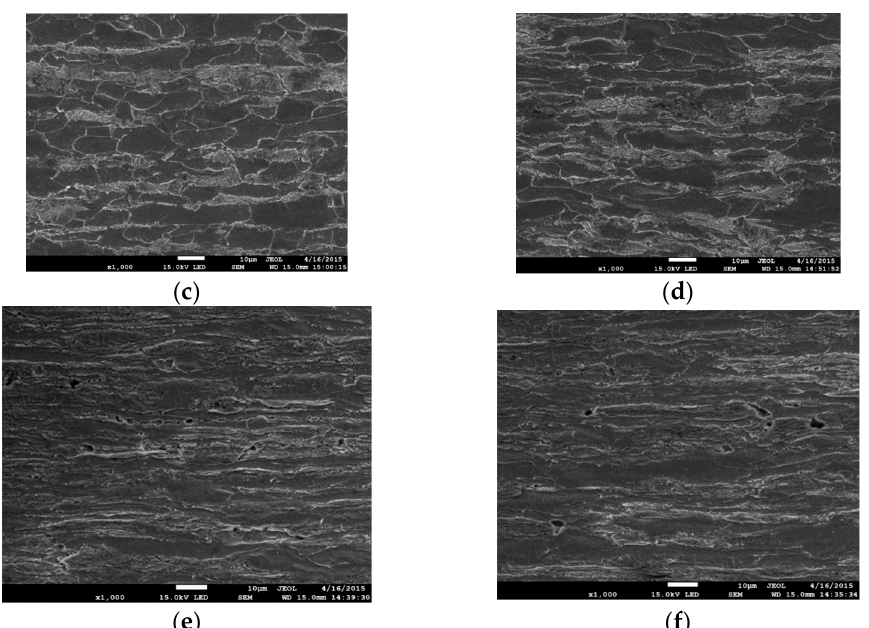
Figure 3. Deformed microstructure of S355 steel at different distance from the fracture plane: ( a ) 17 mm (undeformed material); ( b ) 7 mm; ( c ) 4 mm; ( d ) 2 mm; and ( e , f ) 0.1–0.2 mm.